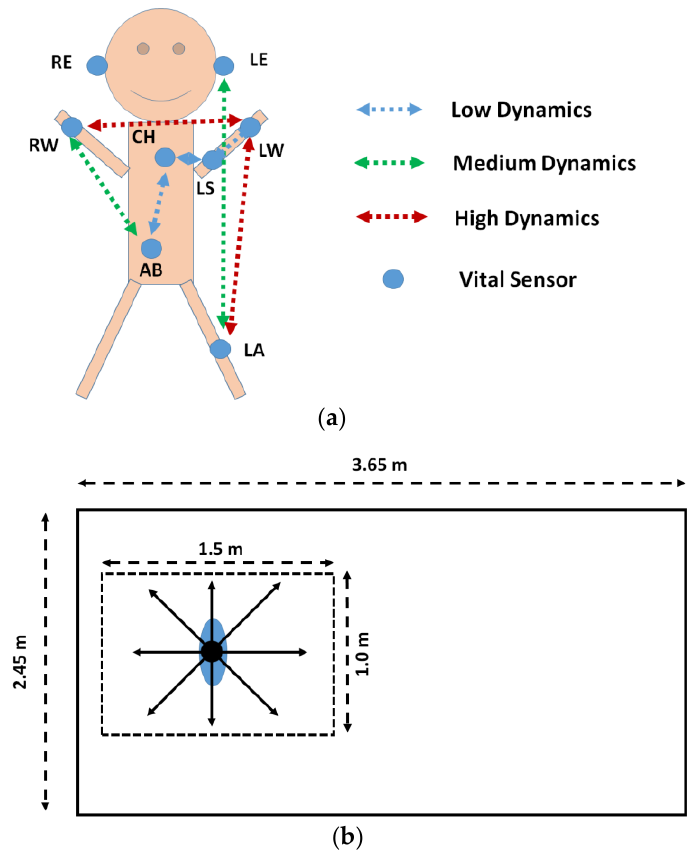
Figure 4. ( a ) On-body antenna locations. ( b ) Test person’s motions.